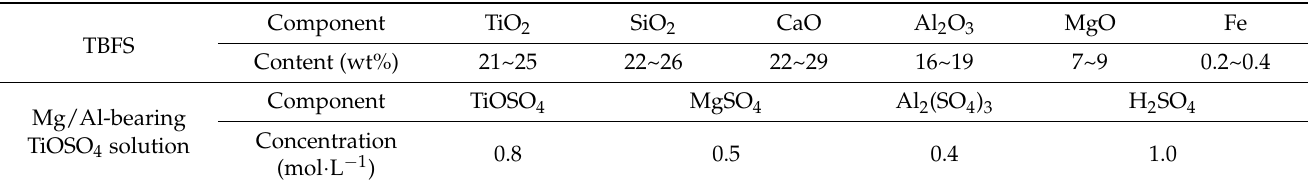
Table 1. Chemical composition of TBFS and the Mg/Al-bearing TiOSO 4